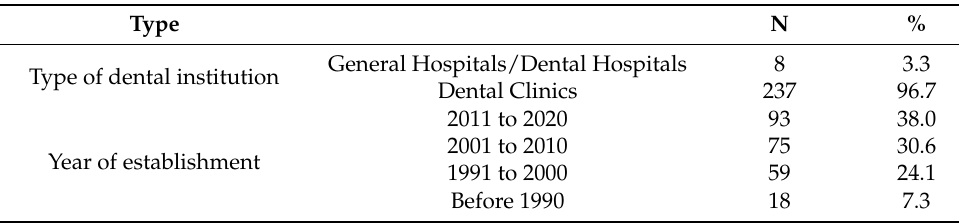
Table 2. General characteristics of the investigated dental institutions.